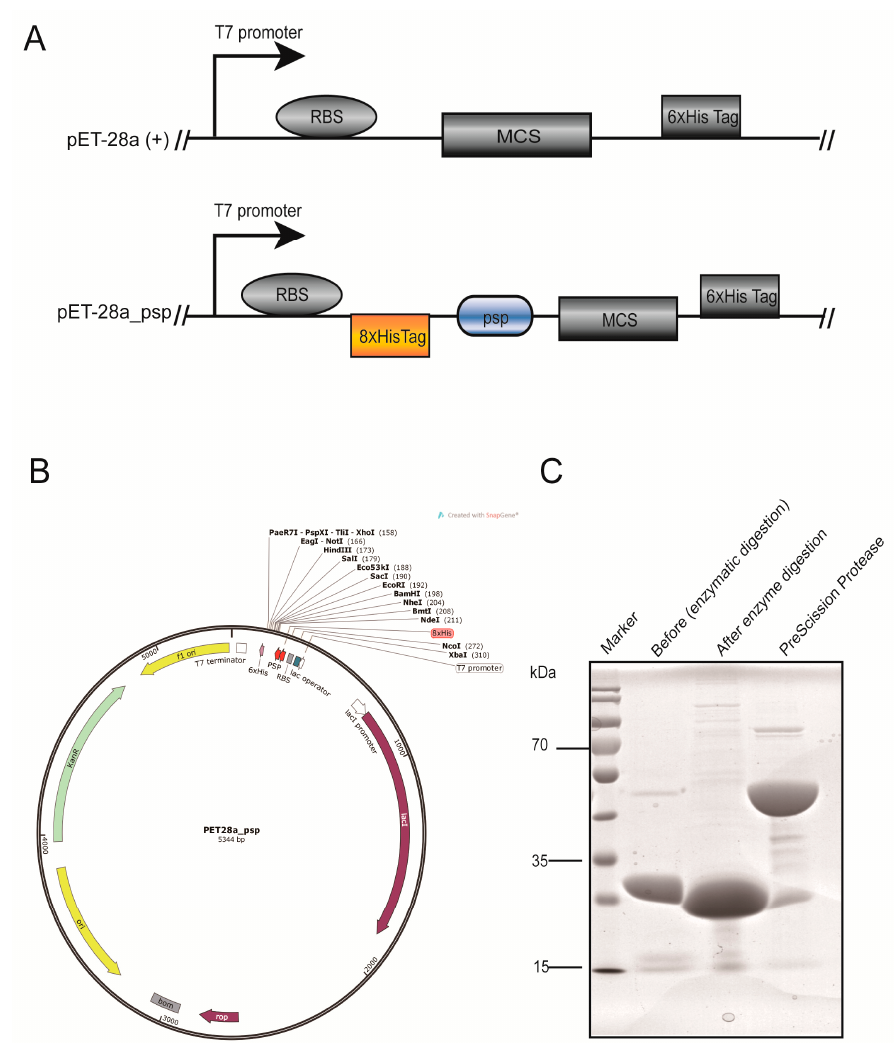
Figure 2. Construction of the pET-28a-psp plasmid and preparation of Prescission Protease. ( A ) The difference between the commercial pET-28a (+) and modified pET-28a_psp vectors. The orange and blue regions are the extra parts of the modified vector. RBS, Ribosomal Binding Site. MCS, Multiple Cloning Site. PSP, Prescission Proteas. ( B ) Map of the pET-28a_psp plasmid. The red region is the site recognized by the Prescission Protease and the position of the 8x His-tag. ( C ) The purity and activity of Prescission Protease were analyzed by SDS-PAGE (15%) and stained by Coomassie Blue.